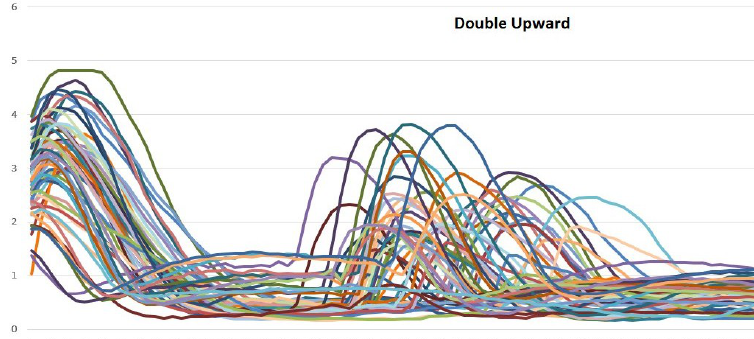
Figure 9. Samples that are related to the double upward movement. The Y -axis represents each sampling point of the vector that is related to each sample and the X -axis represents the signal amplitude (it was mapped between 0 and 5).